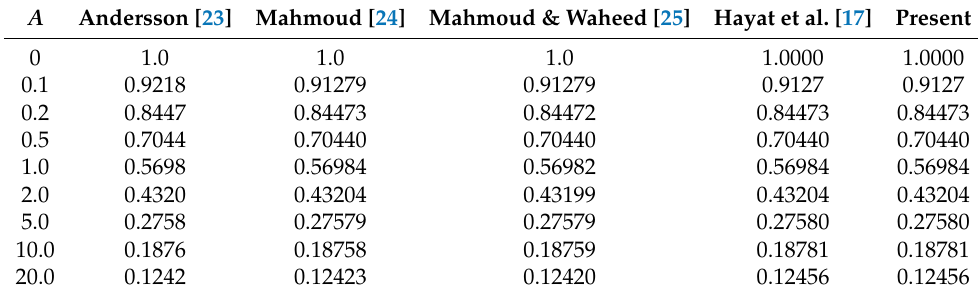
( 0 ) for various values of A when γ = M = 0. 1